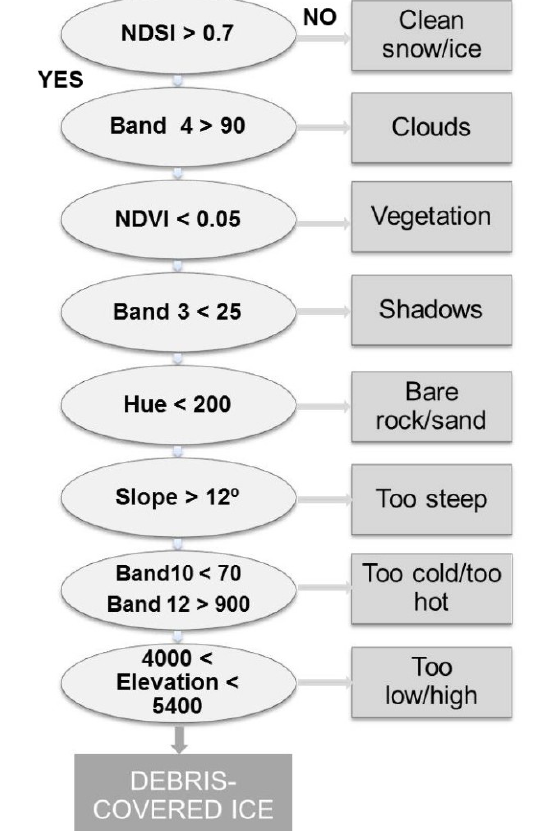
Figure 7. The ENVI decision tree based on topographic and multispectral criteria and thresholds. Each criteria consist in a conditional statement (left side ellipsoids). Every time a condition is fulfilled, the resulting class/binary map (right side rectangular boxes) is excluded from the area of potential debris, resulting in a final map of suitable areas for debris